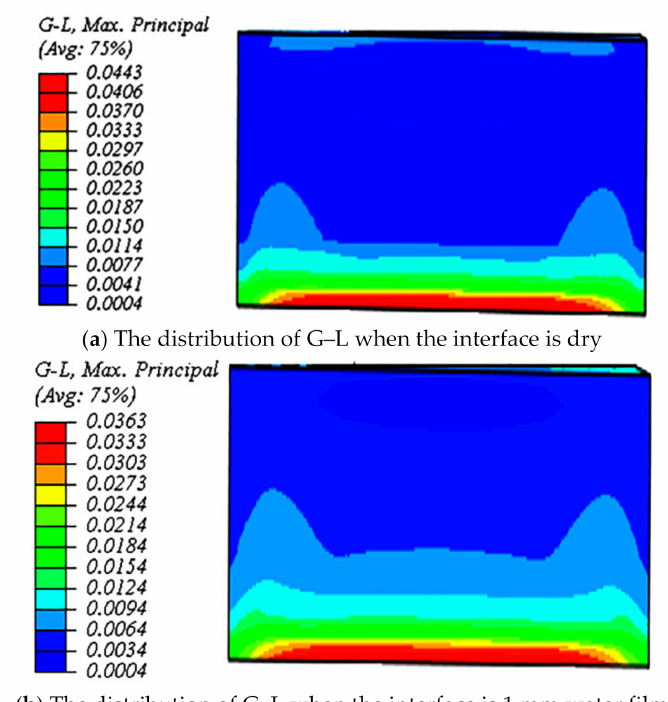
Figure 16. The simulation results of the G–L considering the effects of interface